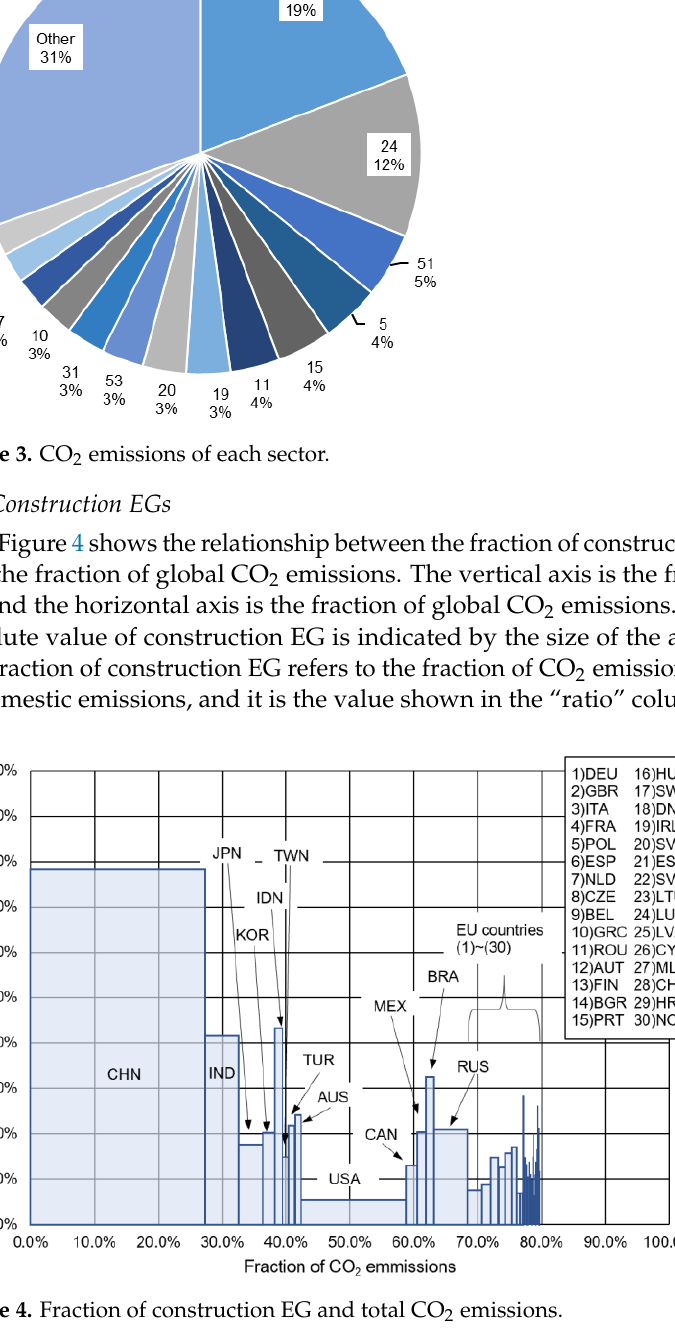
Figure 4. Fraction of construction EG and total CO 2 emissions.